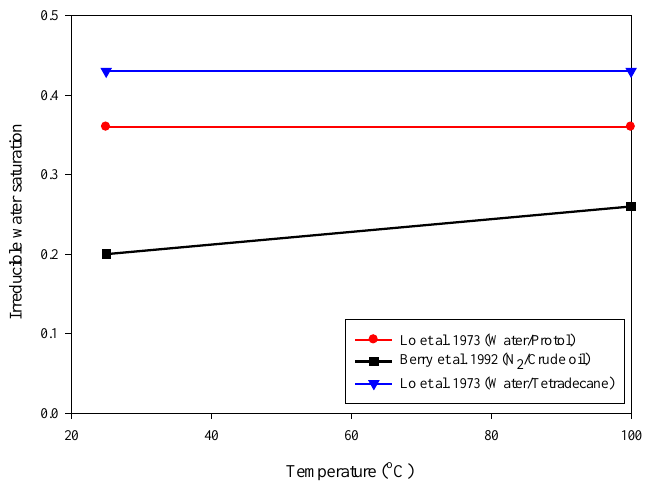
Figure 7. Effect of temperature on irreducible water saturation, reported by Lo et al. [96] and Berry et al. [14]. Berry et al.